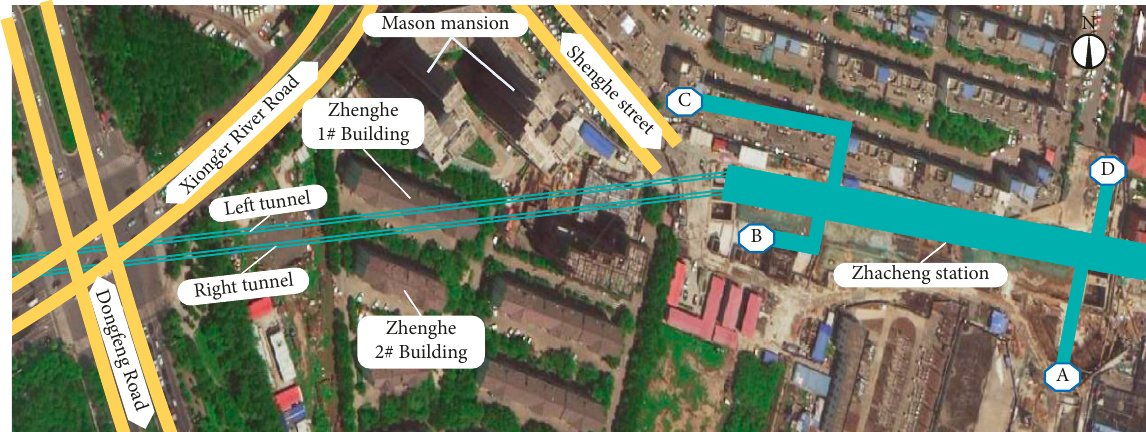
Figure 1: Plan view of shield tunnel cut pile passing through masonry structure.